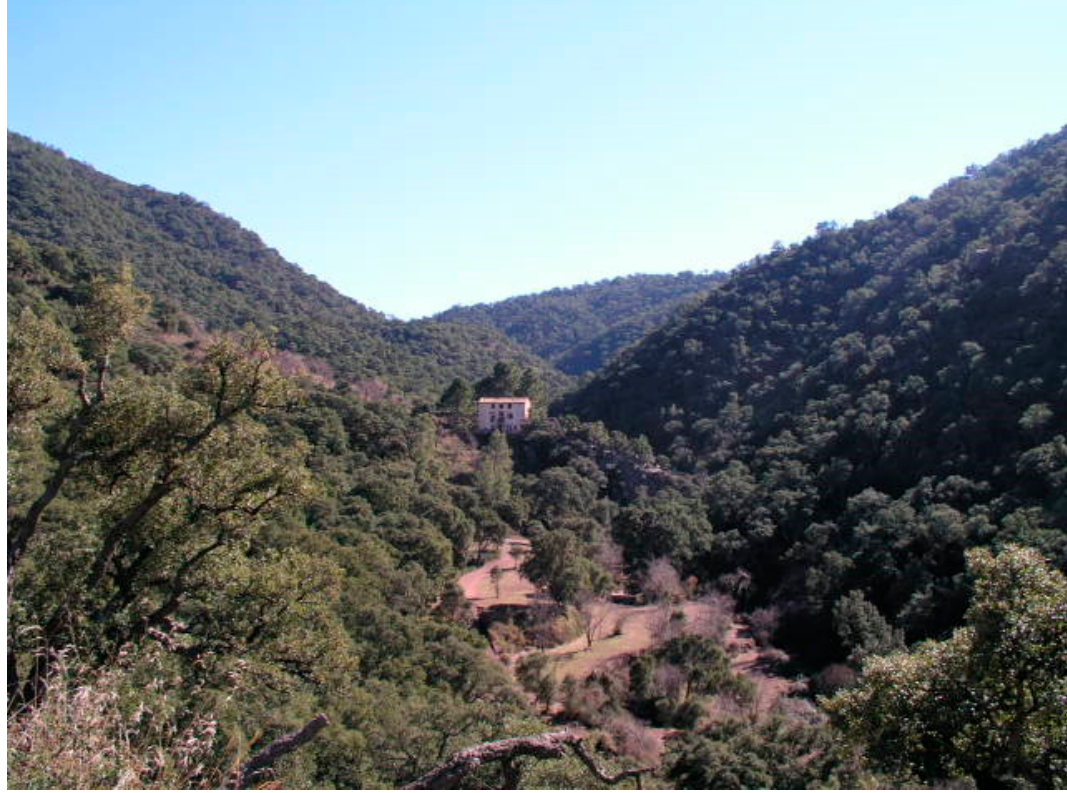
Figure 2. Mosquera valley.